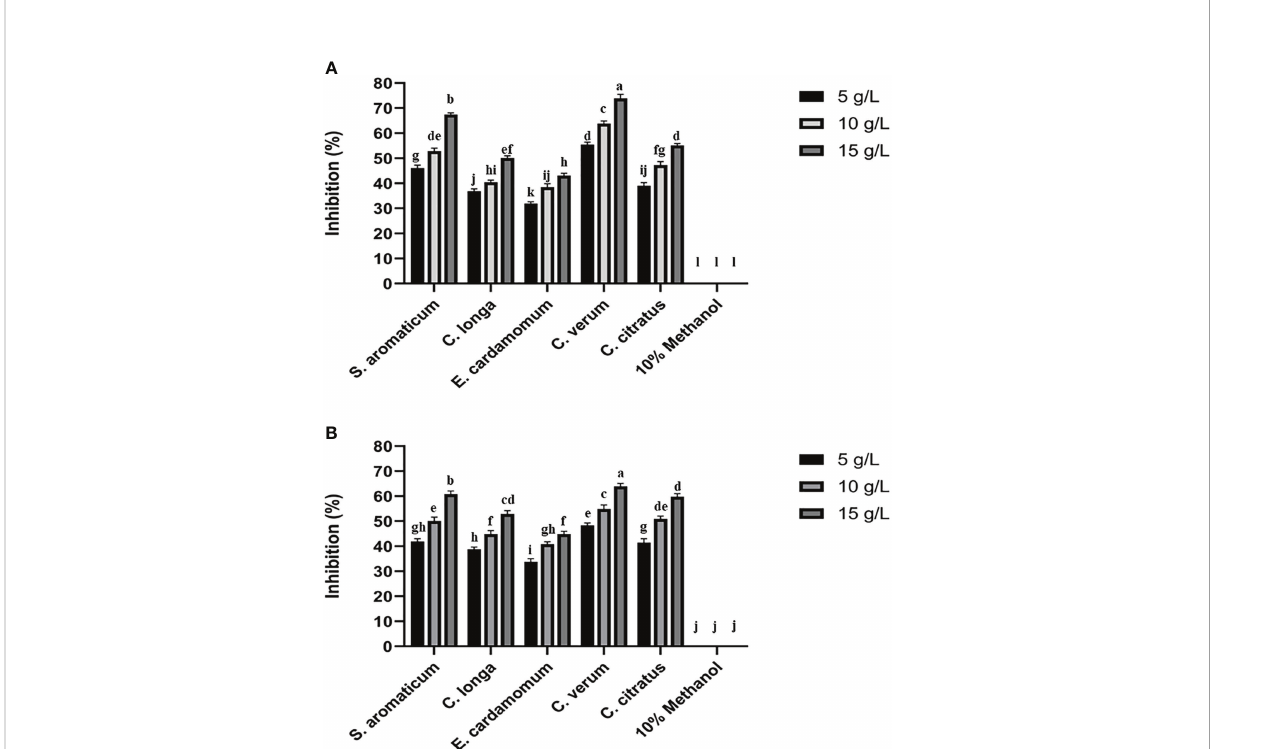
FIGURE 1 Effect of plant extracts on colony growth inhibition of P. digitatum (A) and P. italicum (B) . Error bars represent the standard error (± SE) of treatment means. Means with different alphabets over the columns indicate that the treatments are signi fi cantly different from each